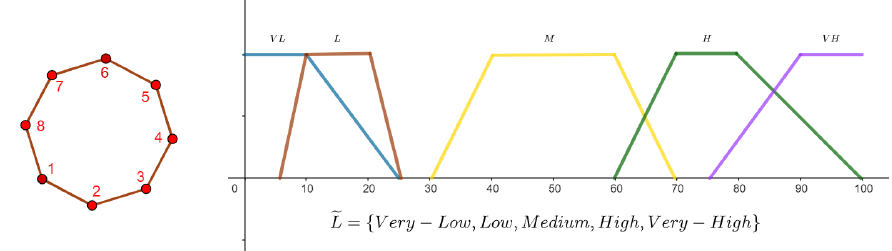
Figure 5. Graph G = ( V , E ) and fuzzy linguistic variable